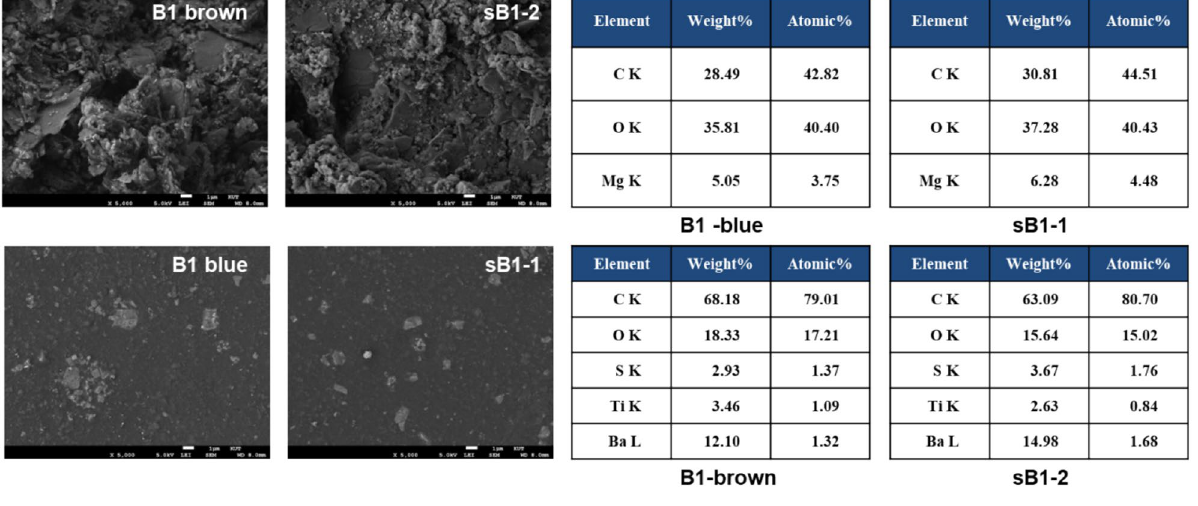
Figure 4. SEM–EDS image of Case II